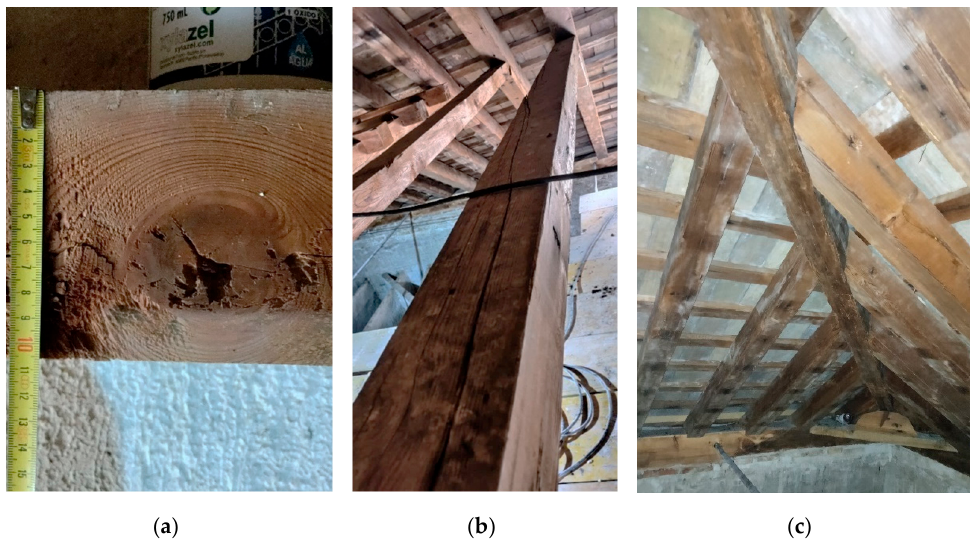
Figure 17. Defects causing pieces to be rejected: ( a ) knot; ( b ) timber check; ( c ) one of the main pieces, which is supposedly rejected by CTE standard parameters.